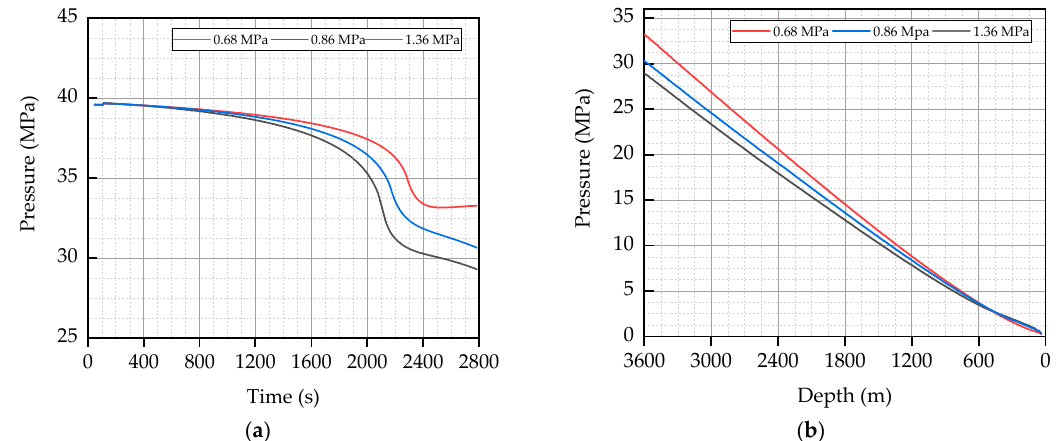
Figure 19. Variation in the bottom hole pressure at different liquid flow rates at different: ( a ) times; and ( b ) depths.